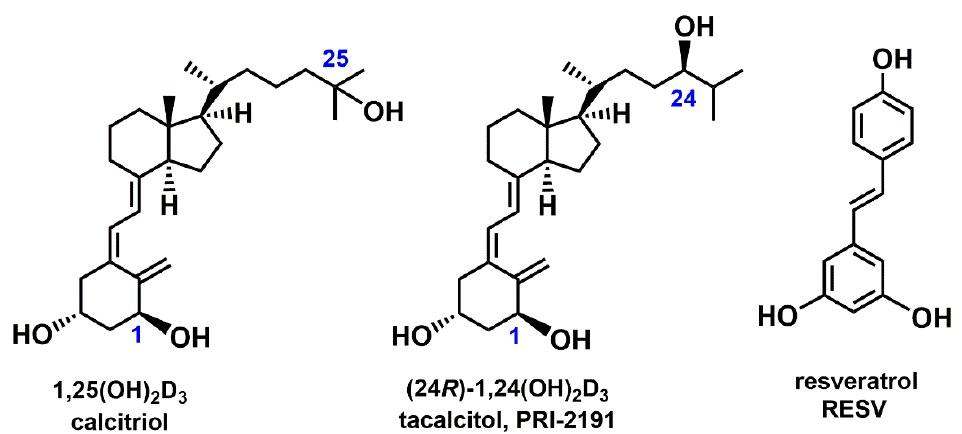
Figure 1. The chemical structure of 1,25(OH) 2 D 3 (calcitriol), (24R)-1,24(OH) 2 D 3 (PRI-2191, tacalcitol), and resveratrol (RESV).